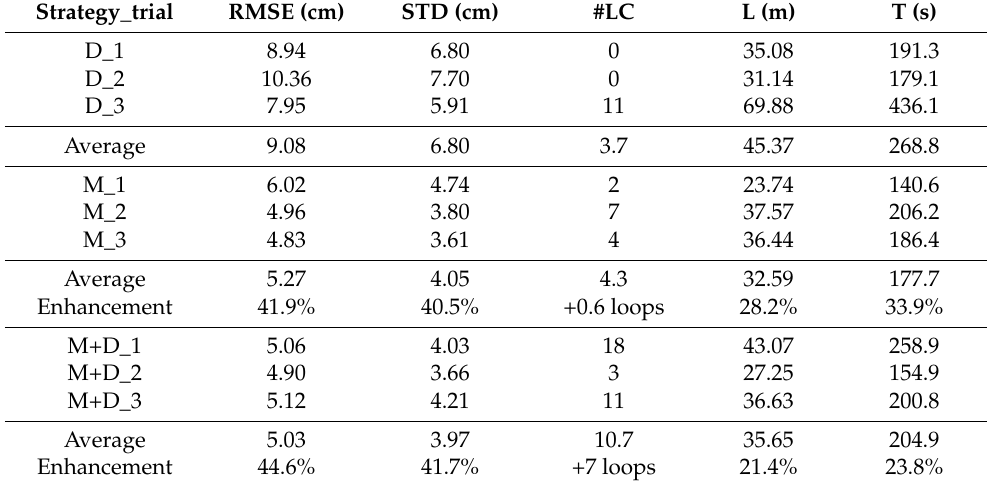
Table 1. Low-texture results. PTPD RMSE (cm), PTPD STD (cm), number of loop closures (LC), exploration path length (L) (m), and exploration time (T) (s).